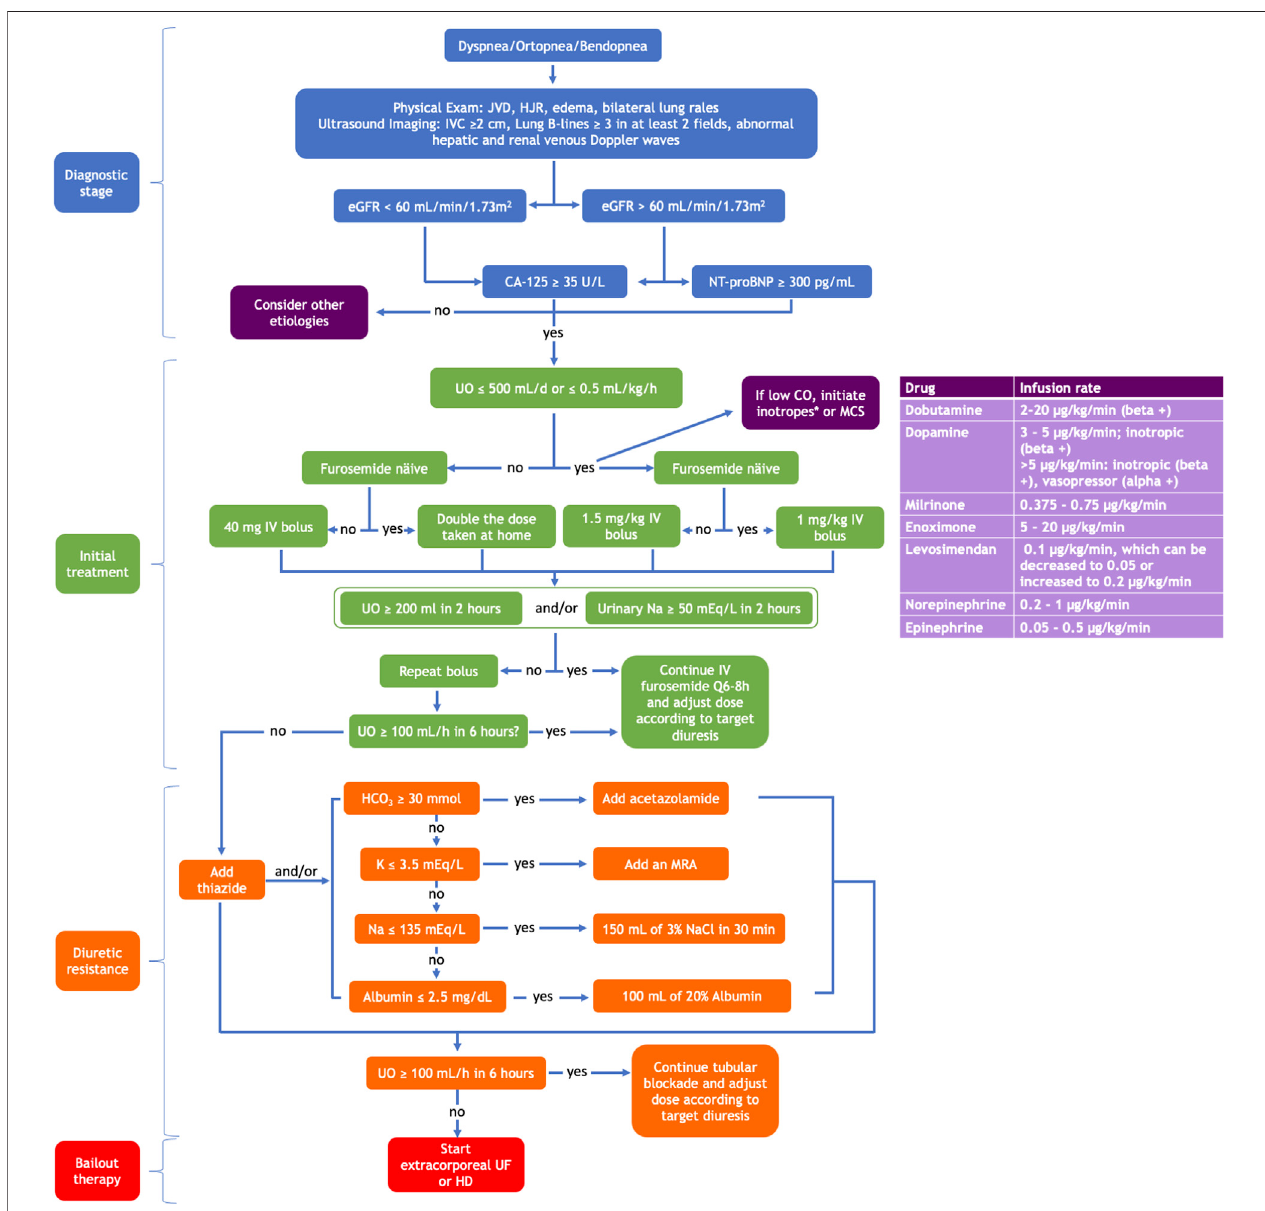
FIGURE 3 | A multimodal approach using clinical assessment, biomarkers, and imaging tools to diagnose heart failure and kidney disease congestion and its stepwise therapeutic algorithm. CO, cardiac output; eGFR, estimated glomerular fi ltration rate; HCO 3 , bicarbonate; HD, hemodialysis; HJR, hepatojugular re fl ux; IV, intravenous; IVC, inferior vena cava; JVD, jugular vein distention; K, potassium; MCS, mechanical circulatory support; MRA, mineral receptor antagonist; Na, sodium; NaCl, sodium chloride; UF, ultra fi ltration; UO, urinary output; *Adapted from the ESC Guidelines for the diagnosis and treatment of chronic heart failure